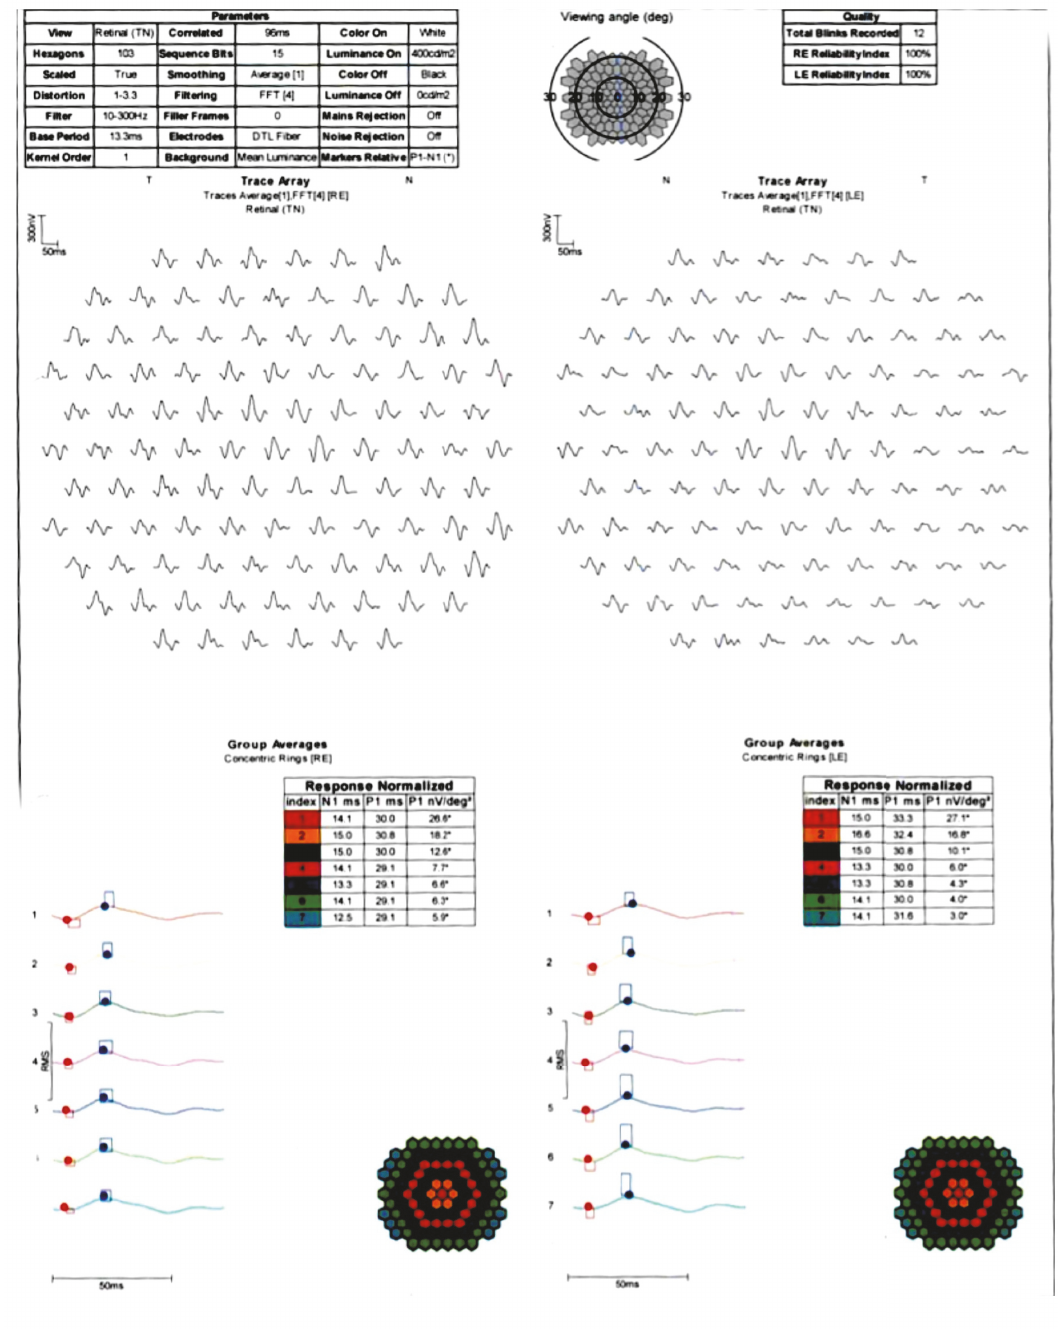
Figure 3: Multifocal ERG with reduced response signal in the area of the temporal retina on the left eye.